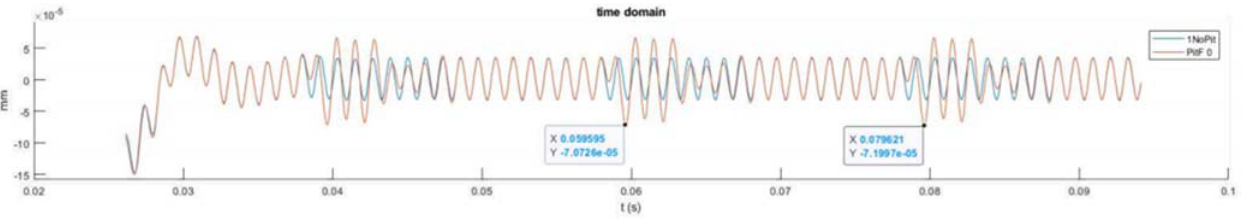
Figure 8. Pressure profile on the meshing gears of the testing gearbox: ( a ) nonpitted spur gears; ( b ) pitted (PitF) spur gears.